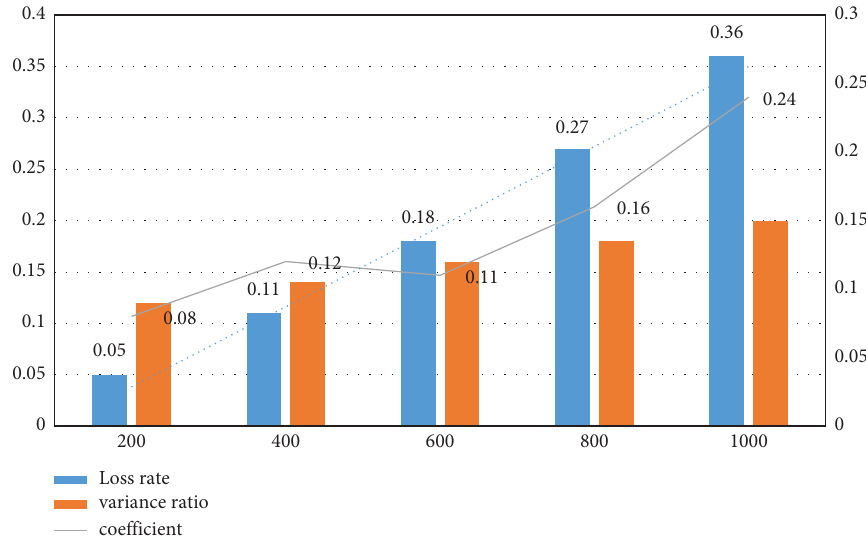
Figure 1: Data packet loss rate. Table 1: Performance